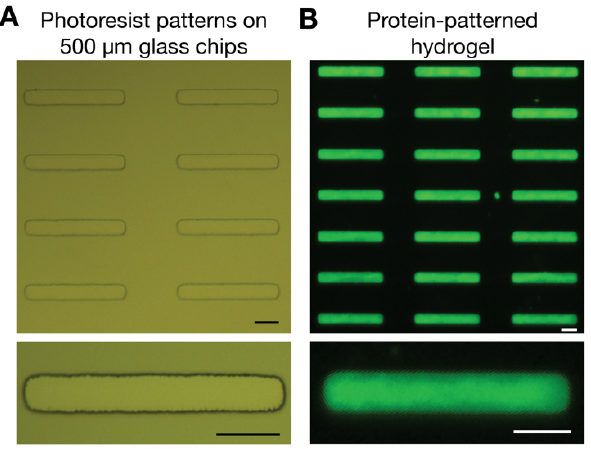
Figure 3. Transfer of protein templates in photoresist on glass chips into protein patterns on hydrogels. ( A ) Developed photoresist templates on glass chips. The developed photoresist templates were stored in a light-protected environment for approximately six months prior to hydrogel fabrication. ( B ) Protein patterns on hydrogels were visualized using fluorescent gelatin. Fluorescent gelatin was transferred from glass chips using polydimethylsiloxane (PDMS) spacers to define the hydrogel thickness. Scale bars denote 25 µm.